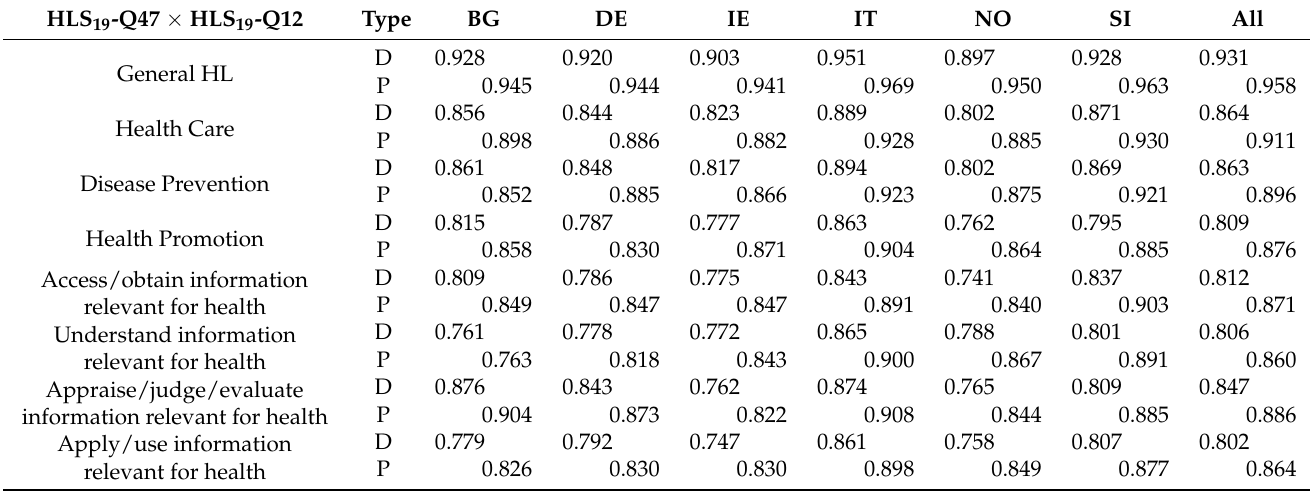
Table 17. Weighted Pearson Correlation of the HLS 19 -Q12 score (D type and P type) and its subdi- mensions with their respective long form based on the HLS 19